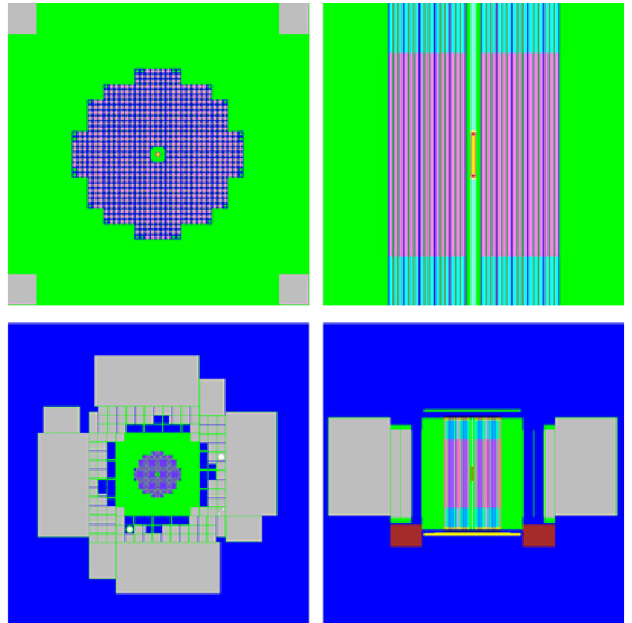
Fig. 4. TRIPOLI4 model of the MAESTRO core.